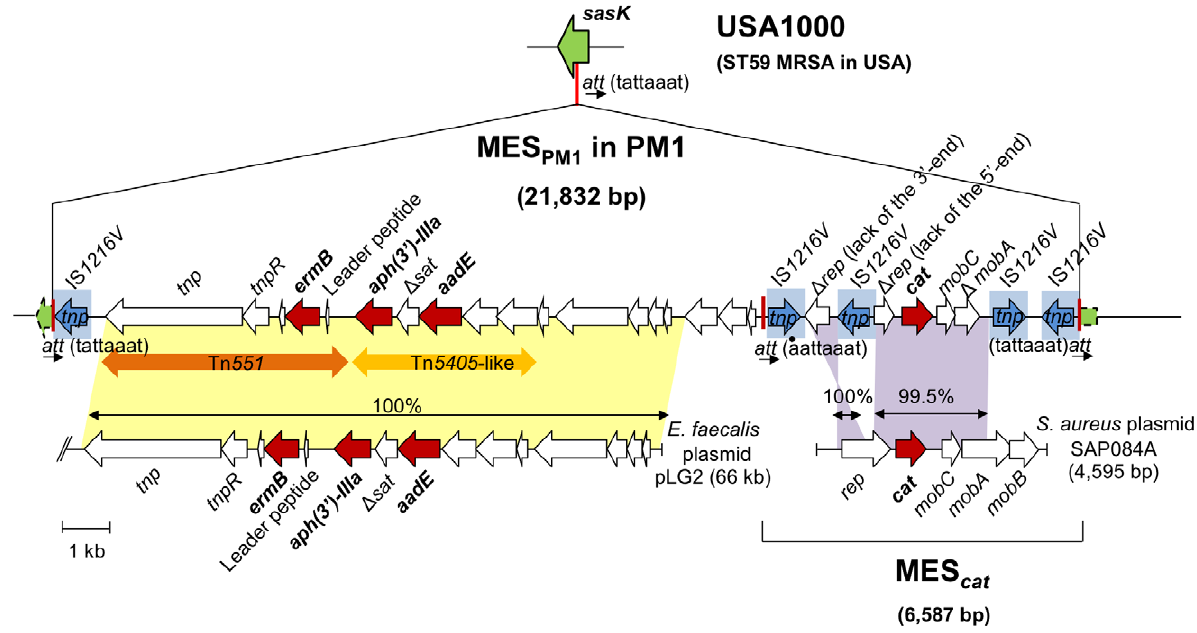
Figure 2. Genetic structure of MES PM1 carrying four resistance genes, ermB , aph(3 9 )-IIIa , aadE , and cat . MES PM1 was integrated into and disrupted the sasK gene, which encoded a putative cell-wall anchored surface protein with the LPXTG-motif. The intact sasK gene was present in PVL- positive ST59 CA-MRSA type strain USA1000. Three att sites are in a vertical red line. The region of IS 1216V with the transposase gene ( tnp ) is shaded in blue. Homology regions with E. faecalis pLG2 plasmid (GenBank accession number HQ426665) and S. aureus SAP084A (GenBank accession number GQ900436) are shaded in yellow and purple, respectively. A Greek delta symbol indicates truncated coding sequence.